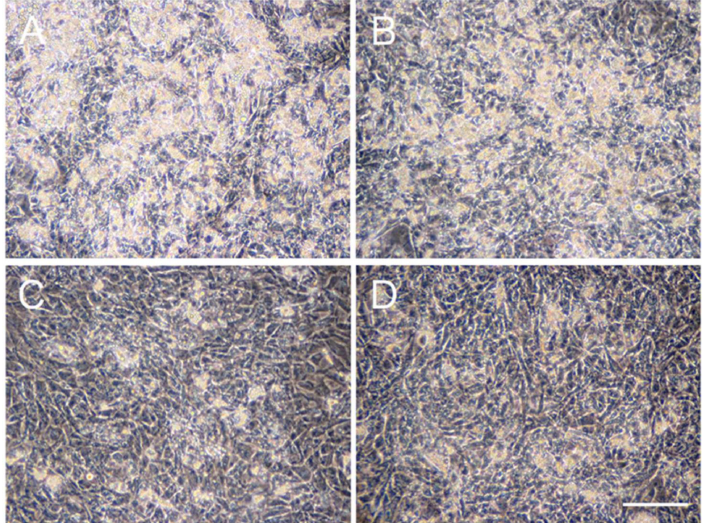
Figure 1. Suppression of adipogenic differentiation of adipose tissue-derived stem cells (ADSCs) by atazanavir (ATV). ADSCs, cultured in serum-free medium until they reached confluence, were incubated in adipogenic differentiation medium for 10 days with varying concentrations of ATV. ( A ) control, ( B ) 5 µ M ATV, ( C ) 10 µ M ATV, and ( D ) 20 µ M ATV. Images were taken under a phase- contrast microscope. White scale bar indicates 250 µ